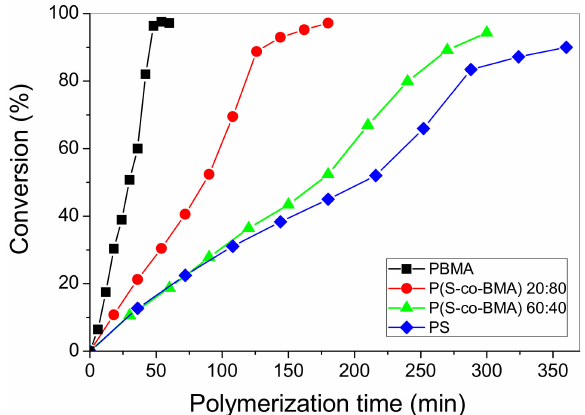
Figure 1. Evolution of conversion with time of the neat copolymers P(S-co-BMA) 20:80 and P(S-co-BMA) 60:40 and the homo-polymers PS [32] and PBMA [25].